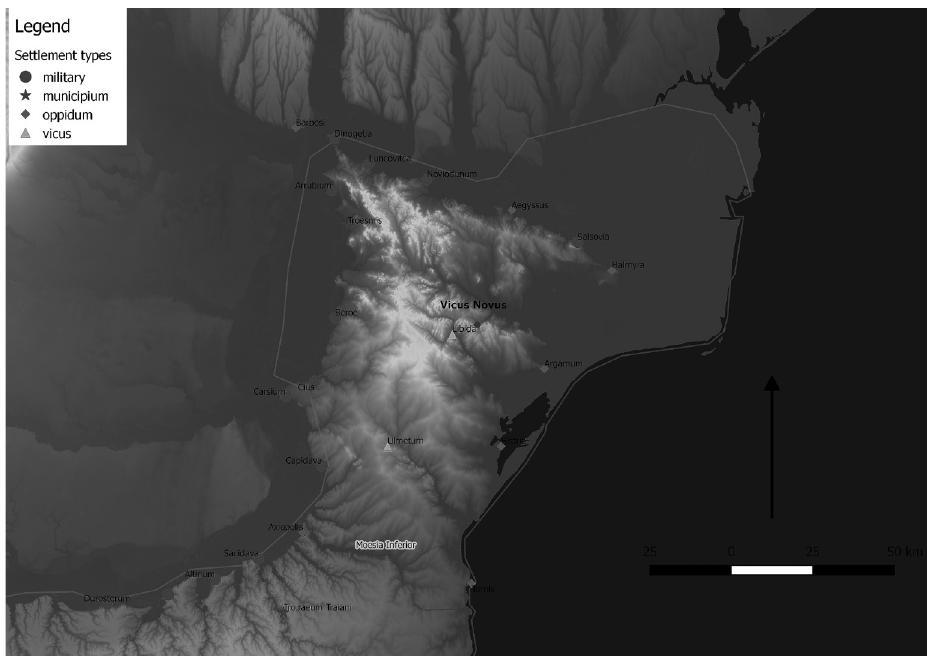
Figure 10: A map of northern